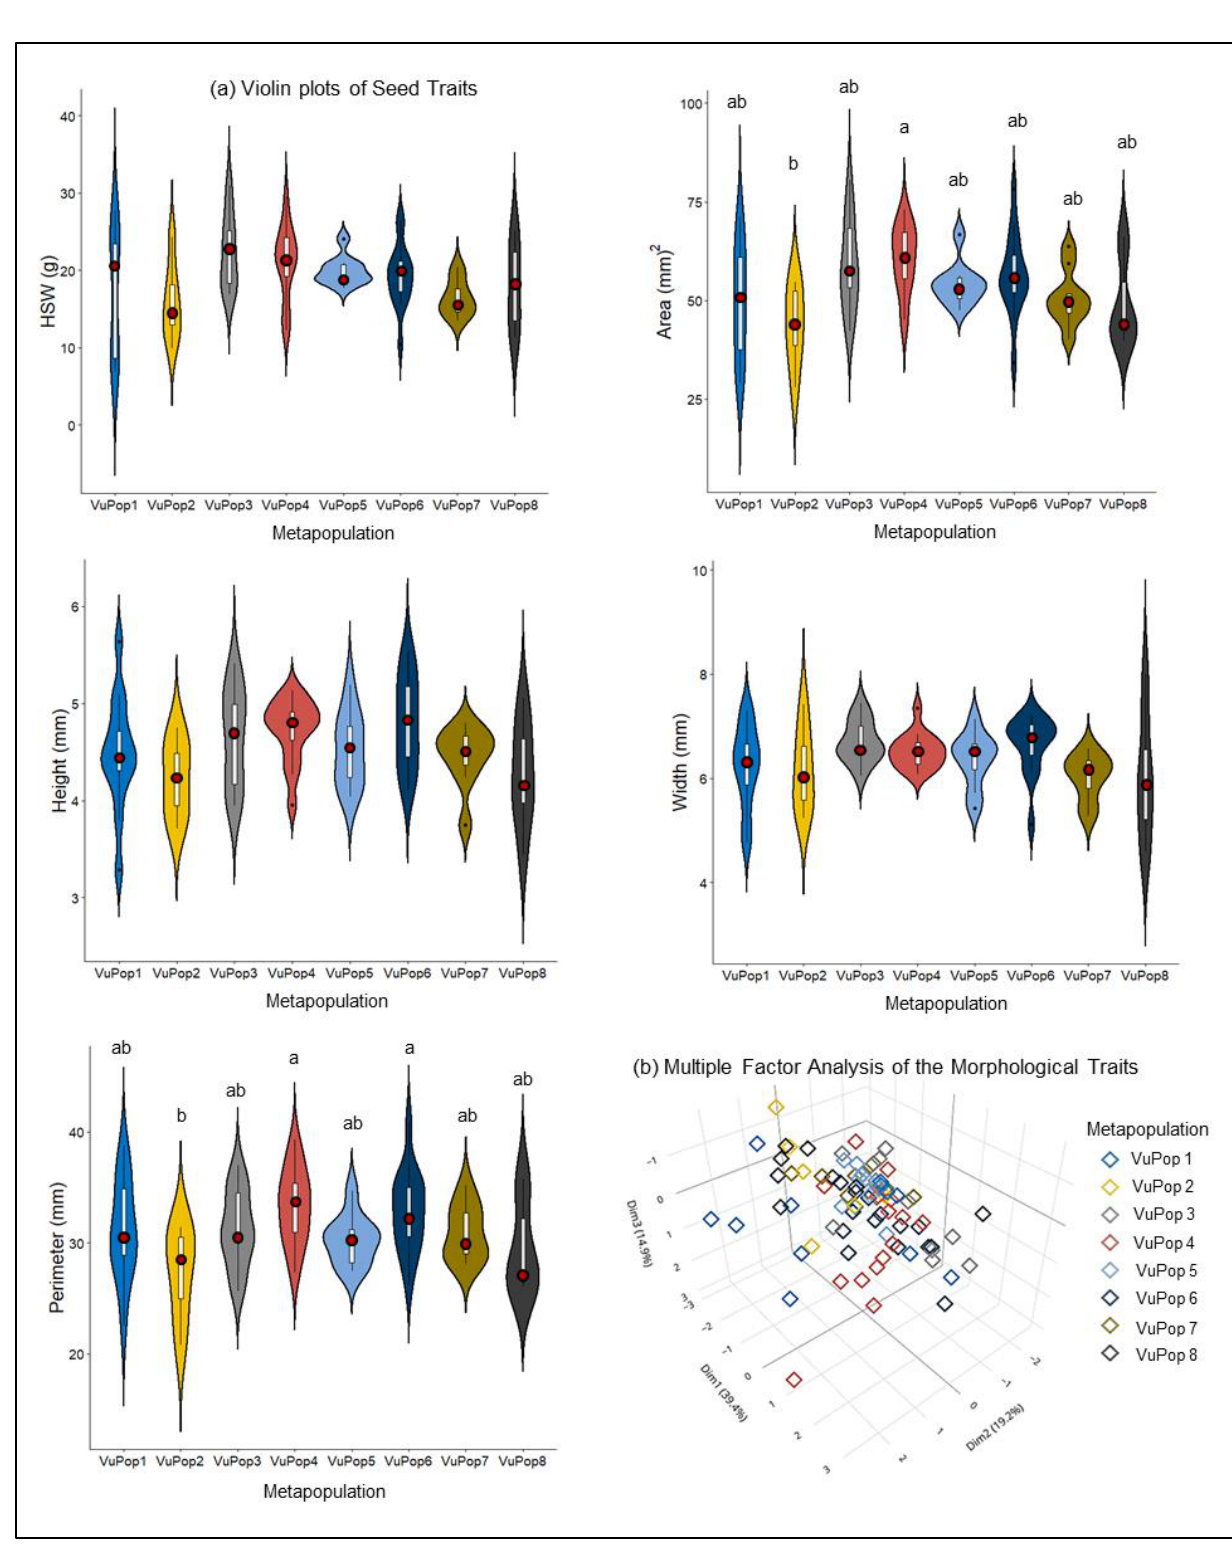
Figure 2. ( a ) Violin plots of the HSW and seed geometrical features for the 8 cowpea metapopulations. Metapopulations that share no common letter are significantly different according to Tukey’s HSD ( p < 0.05); ( b ) Multiple Factor Analysis plot of the cowpea metapopulations’ seed features, where the first three axes explain 73.5% of the observed variability.